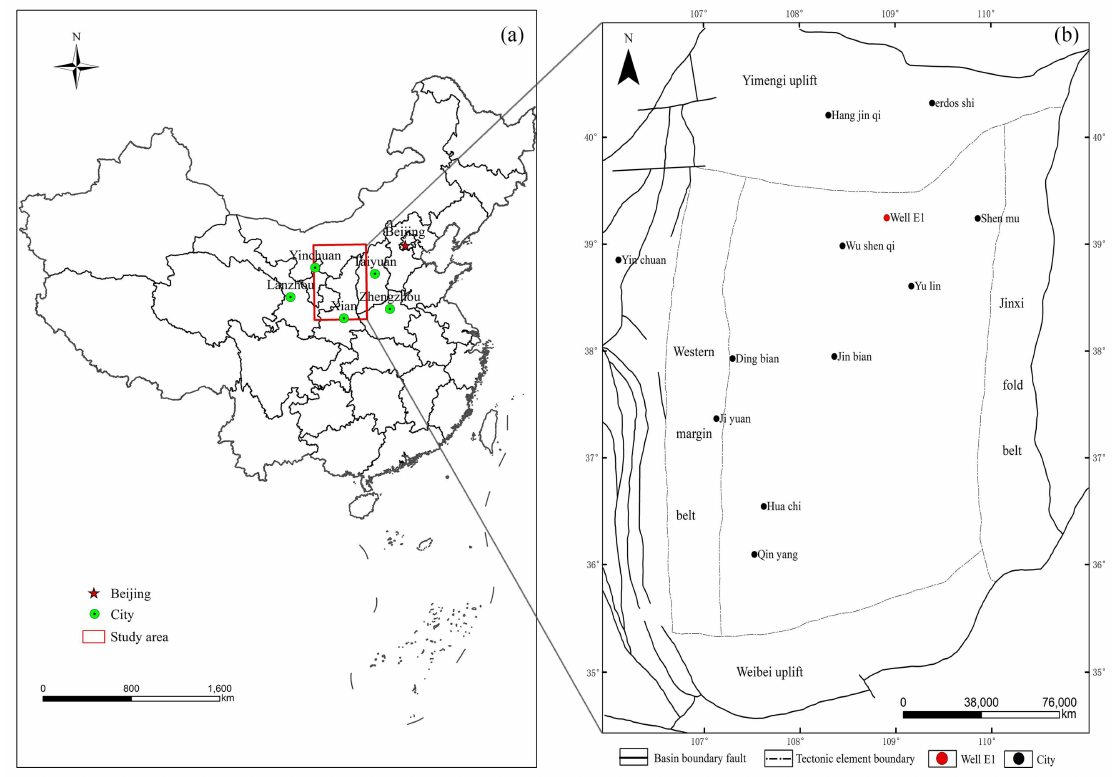
Figure 3. ( a ) The location of Ordos Bin in China and ( b ) the structural belts of Ordos Basin and the sampling well near the Yimeng